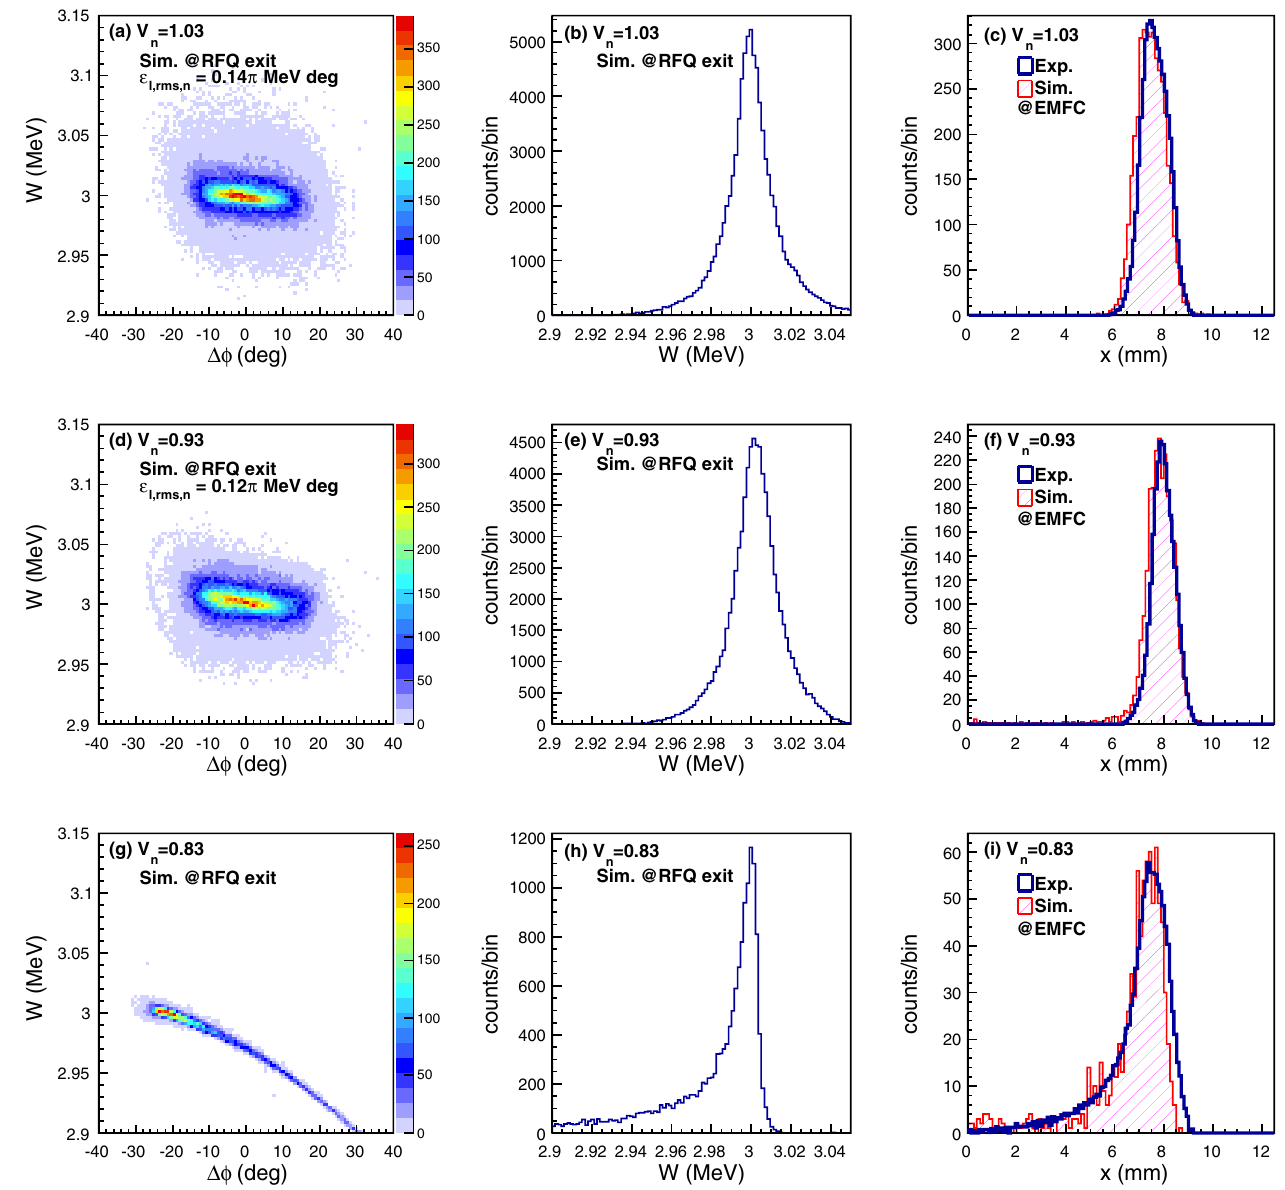
FIG. 10. Longitudinal emittances and energy spreads at the exit of RFQ III, where the simulation results are given in (a), (b), (d), (e), (g), and (h), and the measured and simulated transverse beam profiles at the EMSLx are given in (c), (f), and (i) for BM ¼ 84 A. Exp. and Sim. denote the experiment and simulation results, charge neutralization of the two test stands. The input distribution for LINACS RFQ SIM was reconstructed from the measured distribution using GEN B EAM [19]. transmission through the RFQ. V n denotes the intervane voltage of the RFQ normalized to the nominal voltage, and the vertical axis is the trans- mission. The solid and dashed lines represent the measured and simulated transmissions of the accelerated particles, respectively. The accelerated beam current was obtained by measuring the 324-MHz spectrum of the FCT2 signal using a Tektronix [20] MDO4014B-3 mixed-domain oscilloscope.